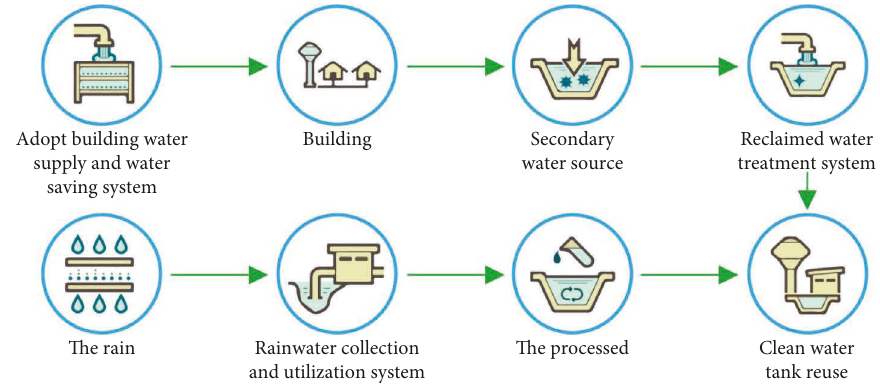
Figure 1: Guidelines for green building